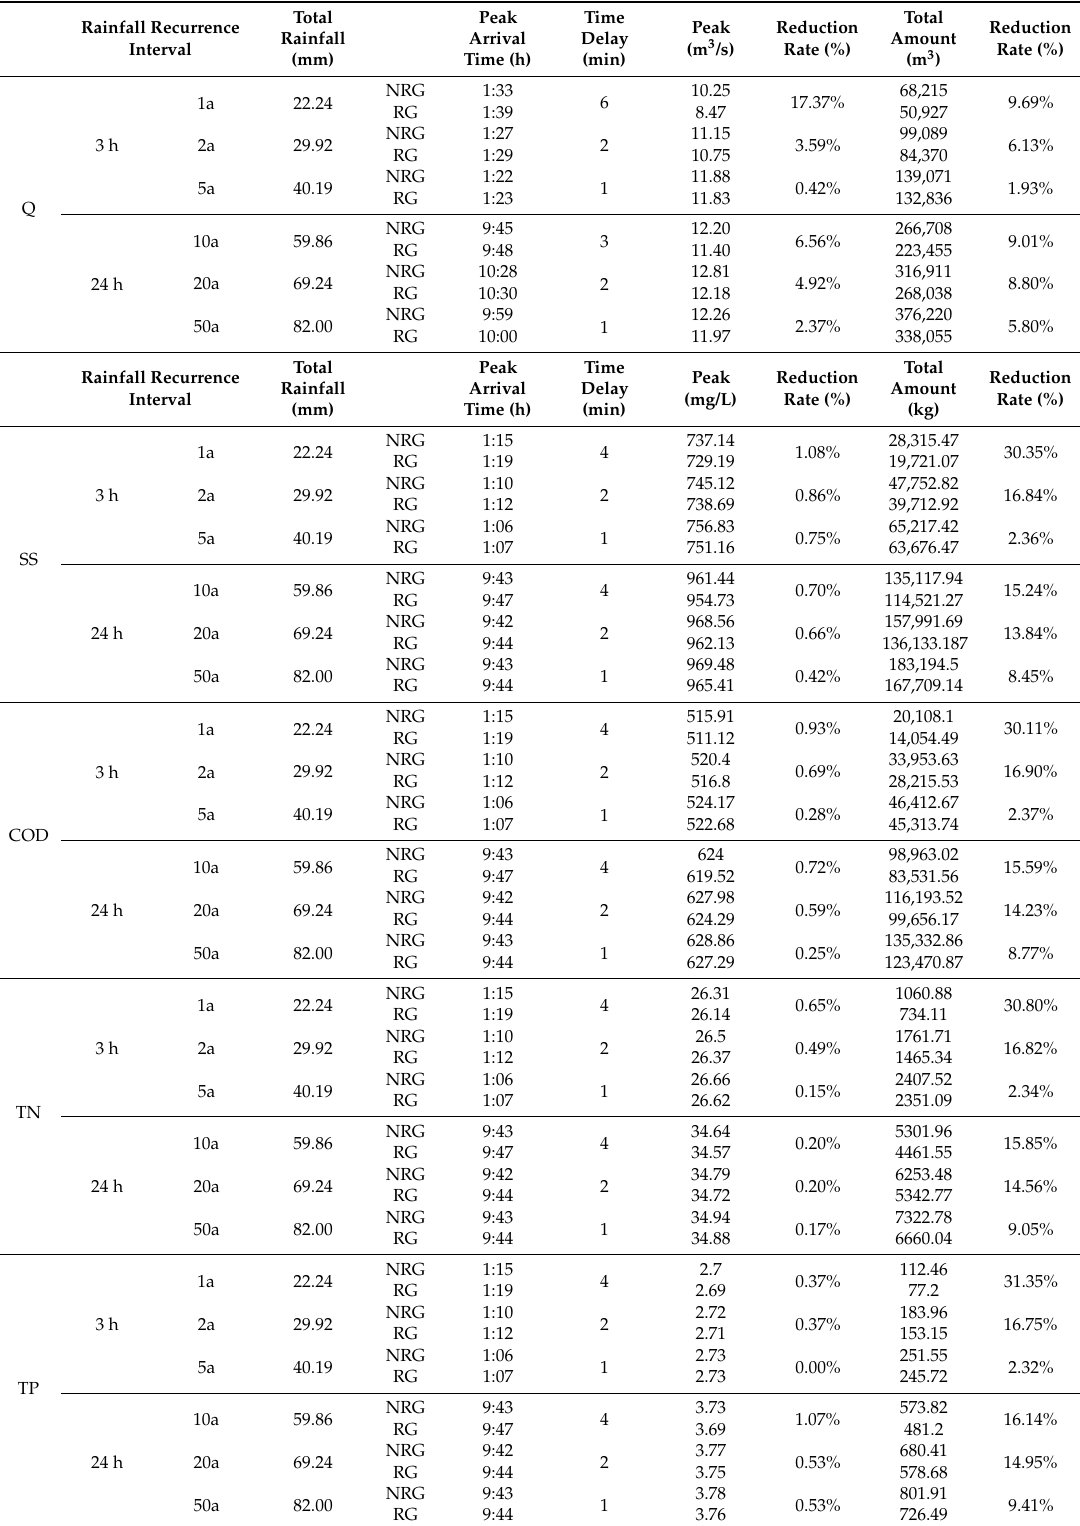
Table 4. Simulation results of outlet discharges and pollutions under different design